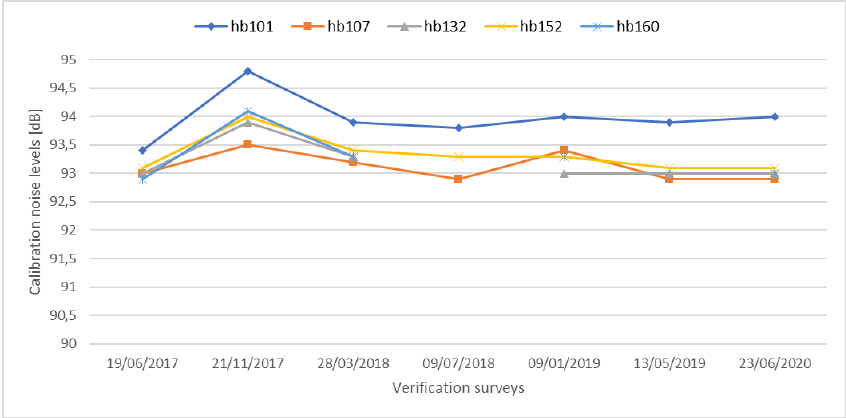
Figure 2: 1 kHz calibration check – Electret sensors placed on building’s